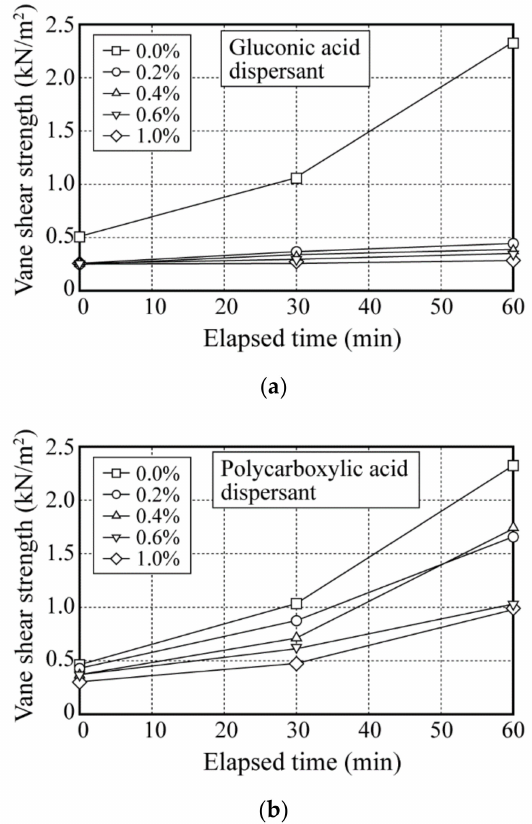
Figure 9. Effect of dispersant on increases in strength of the soil and binder mixture [14]. ( a ) Glycolic acid dispersant; ( b ) polycarboxylic acid